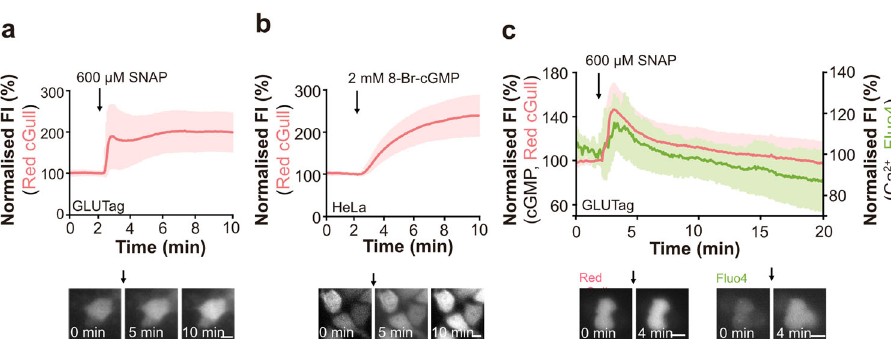
Fig. 3 Visualisation of intracellular cGMP dynamics by Red cGull. a Time course of FI (top) and sequential images (bottom) of GLUTag cells expressing Red cGull during the application of 600 μ M SNAP. Data were means (line) ± standard deviation (s.d.) (shaded area) ( n = 17 cells from three independent experiments). The scale bar represents 10 μ m. b Time course of FI (top) and sequential images (bottom) of HeLa cells expressing Red cGull during the application of 2 mM 8-Br-cGMP. Data are means ± s.d. ( n = 21 cells from four independent experiments). The scale bar represents 10 μ m. c Time courses of FI of Red cGull (pink line) and Fluo4 (green line) and sequential images (bottom) of Red cGull-expressed and Fluo4-loaded GLUTag cells during the application of 600 μ M SNAP. Data were means± s.d. ( n = 12 cells from three independent experiments). Scale bars represent 20 μ m.